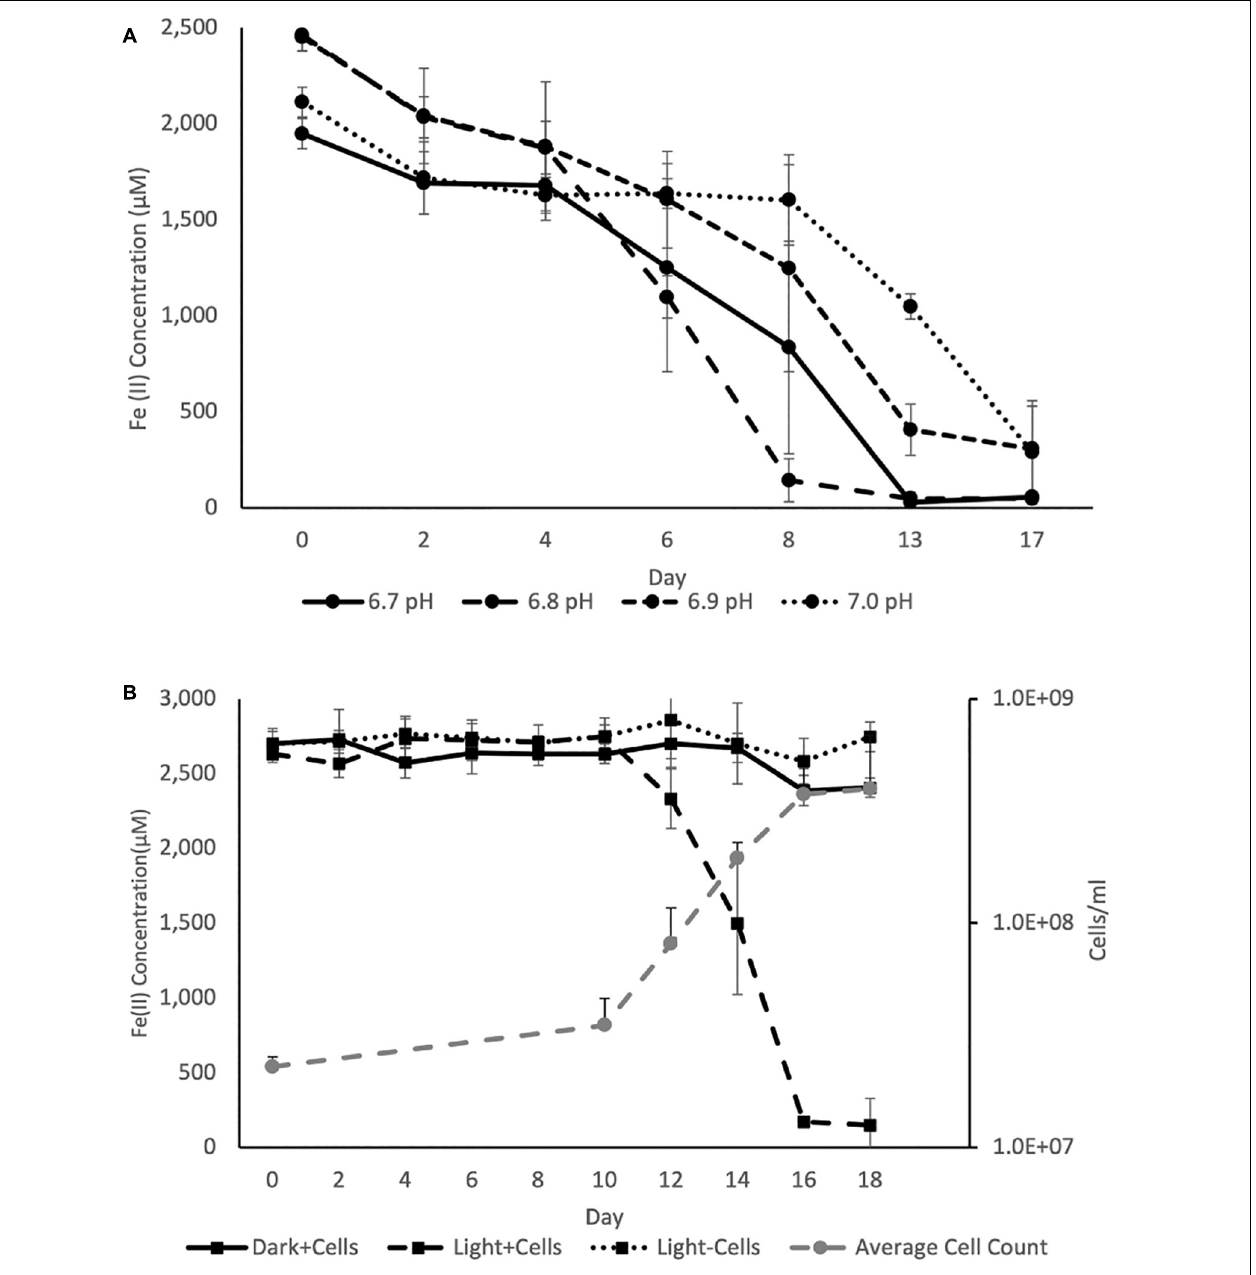
FIGURE 4 | (A) Average Fe(II) oxidation curves for triplicate BLA1 incubations under illumination at different pH, showing optimal activity at pH 6.8. (B) Representative growth and Fe(II) oxidation of BLA1 from one triplicate. Error bars represent the standard deviation of analytical triplicates for Fe(II) (in all cases smaller than symbol size) and the standard deviation of all fields of view counted for cell